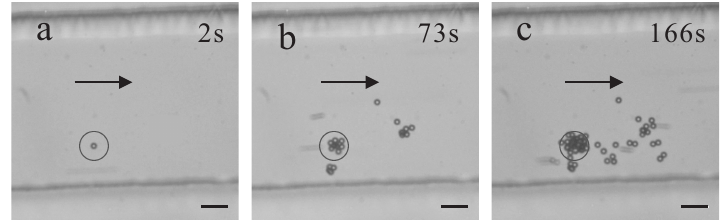
Figure 7. Optical trapping of a number of particles leads to aggregation in the micro-channel. ( a ) initially, optical tweezers trap one particle and flows quickly through the micro-channel; ( b , c ) more particles are trapped by the diffraction fringes, and more and more particles are settled in the micro-channel. The laser power is 1.5 W; scale bar, 10 µ m; the circles indicate the optical trap and the arrows indicate the flow